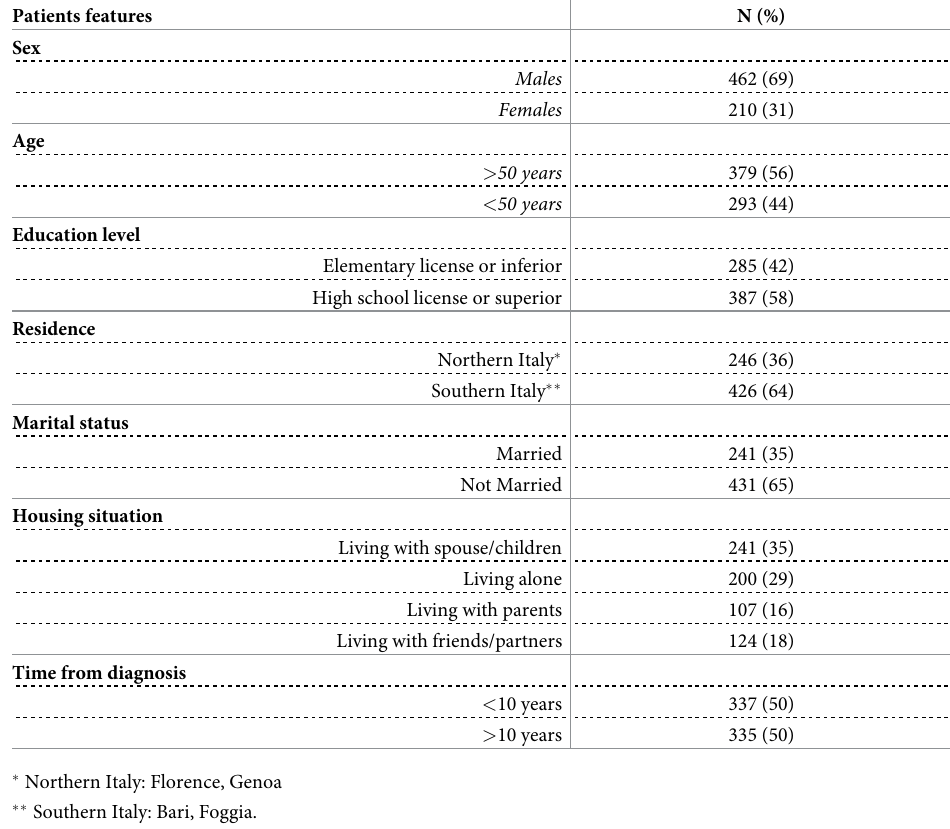
Table 1. Socio-demographic characteristics of 672 PLWHIV participating the survey. Patients